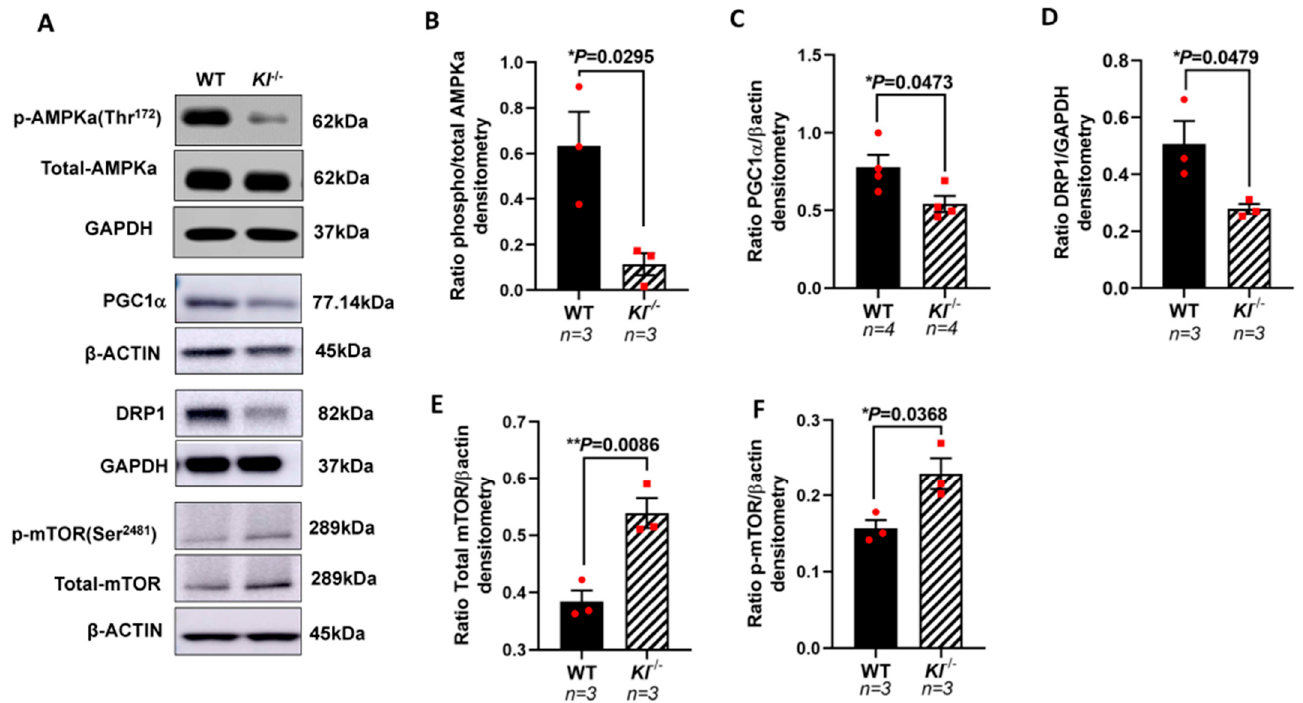
Figure 4. Reduced AMPK, PGC-1 α , and DRP1 proteins, and increased mTOR protein expression in the RPE/retina of Kl -/- mice. ( A ) Immunoblots of total AMPK and phosphorylated AMPK (Thr172), PGC-1 α , DRP1, mTOR and phosphorylated mTOR (Ser2481) in control (WT) and Kl -/- mice RPE/retina. ( B ) The ratios of phospho-AMPK/total AMPK were determined using densitometry analyses, showing decreased AMPK activity in the RPE/retina of Kl -/- mice. ( C , D ) The PGC-1 α and DRP1 levels normalized to β -actin and GAPDH, respectively, were significantly reduced in the Kl -/- mice, as compared to WT mice. ( E , F ) Both total mTOR level and phosphorylated mTOR (Ser2481) levels were increased in the RPE/retina of Kl -/- mice. The β -actin levels were used for normalization. Densitometry analyses were performed using ImageJ software. The unpaired t -test was performed using GraphPad Prism 8.3.0. Graph represents mean ± SEM, * p ≤ 0.05, ** p ≤ 0.01. n = 3~4, both male and female mice were included in each